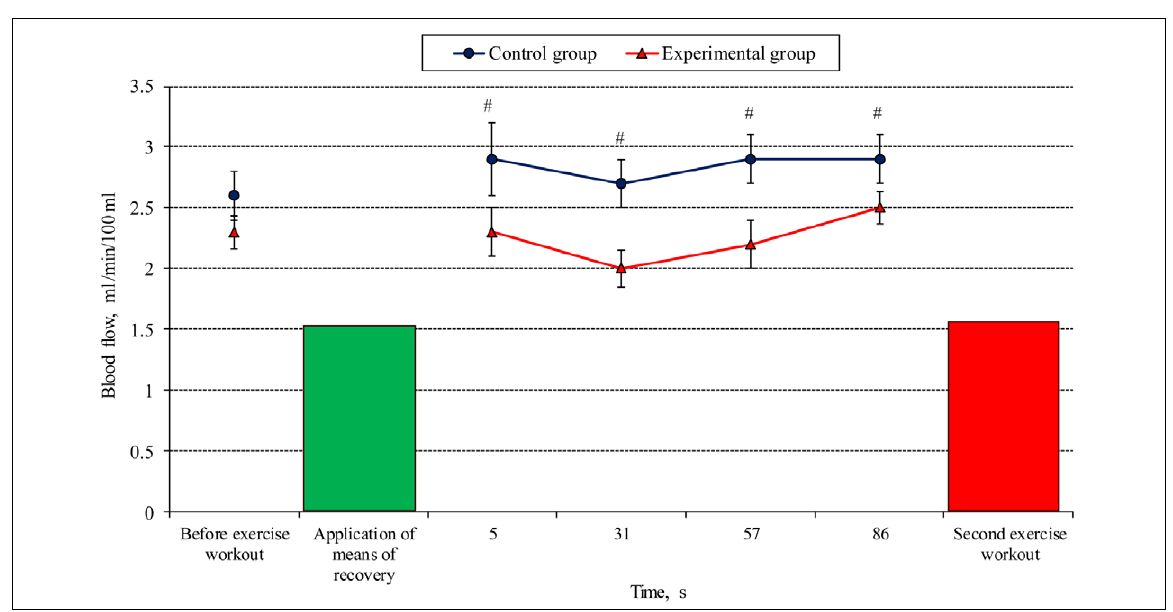
Figure 2. Arterial blood flow in the calf muscle after applying means of recovery (the passive rest and passive foot